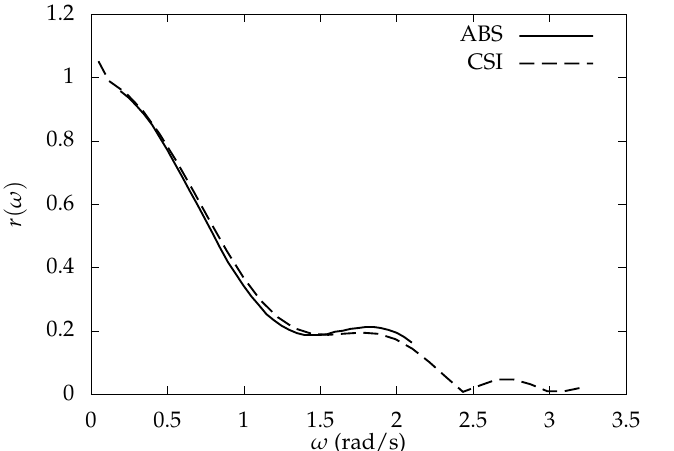
Figure 17. Effective wave slope function for barge computed using the simplified “formal” method. Table 6. Level 2 assessment of dead ship failure mode for